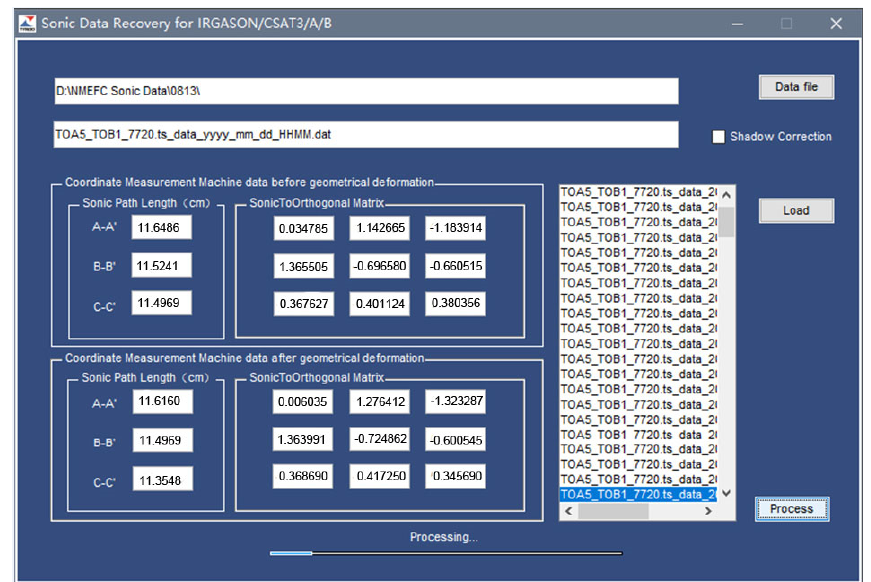
Figure 6. Dialogue interface of software: sonic data recovery for IRGASON/CSAT3/A/B used in geometrical deformation after production and